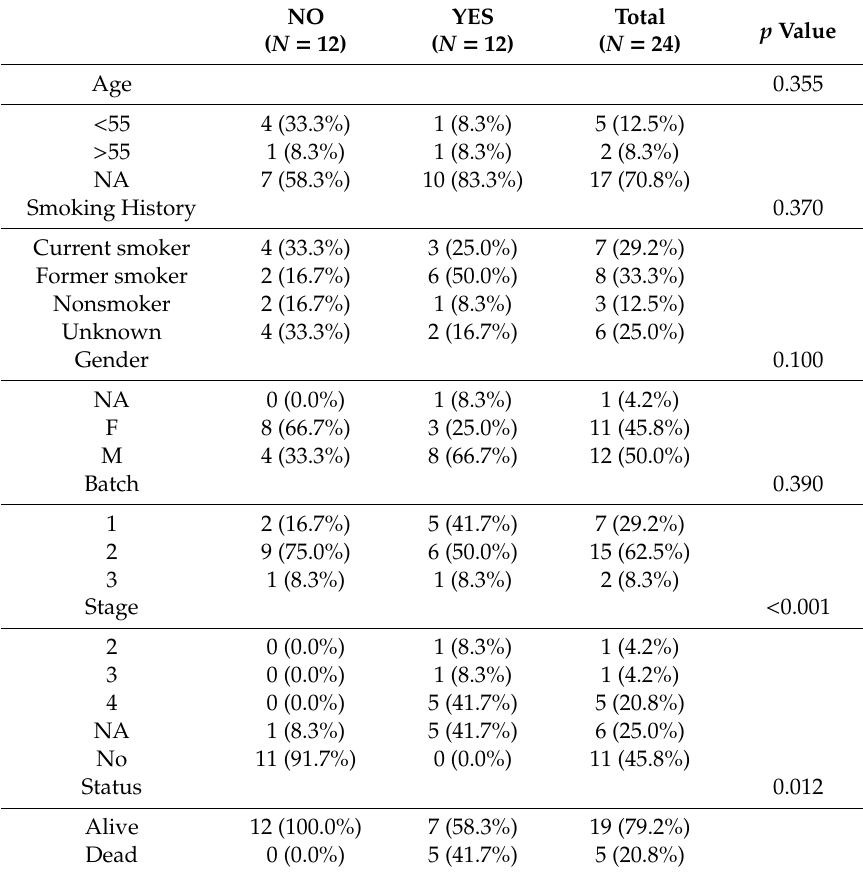
Table 1. Baseline characteristic of the clinical